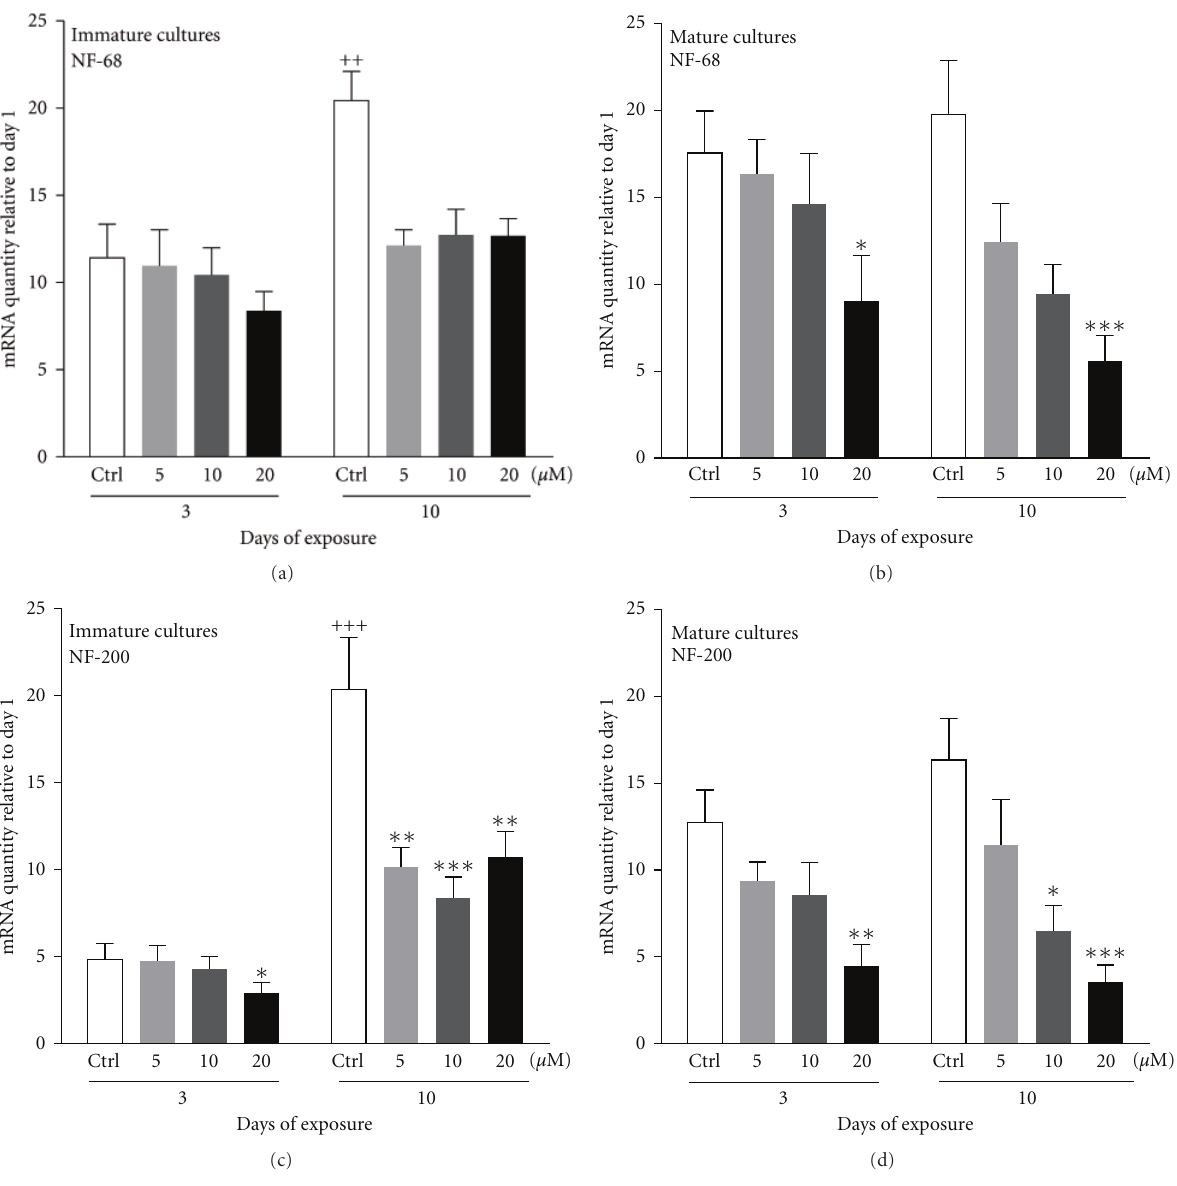
Figure 1: Changes in the mRNA levels of NF-68 and 200 in primary cultures of CGCs exposed to domoic acid (5 μ M, 10 μ M, and 20 μ M) at 1 DIV (immature cultures) or at 7 DIV (mature cultures) for 3 or 10 days. Note the significant downregulation of (a) NF-68 in immature cultures after 10 days of exposure, (b) NF-68 in mature cultures, (c) NF-200 in immature cultures, and (d) NF-200 in mature cultures. Gene expression levels were normalized to the standard calibrator, the housekeeping gene 18S rRNA and the mRNA expression at 1 DIV. Data represent mean ± S.E.M. of three independent experiments performed in duplicates. + P < 0 . 05 ++ P < 0 . 01 +++ P < 0 . 001 comparing control cultures at 3 and 10 days. ∗ P < 0 . 05 ∗∗ P < 0 . 01 ∗∗∗ P < 0 . 001 comparing treated to control (untreated)